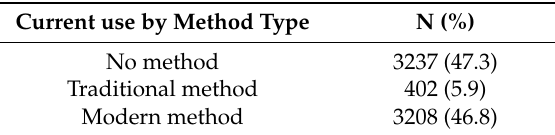
Table 2. Prevalence of contraceptive use by